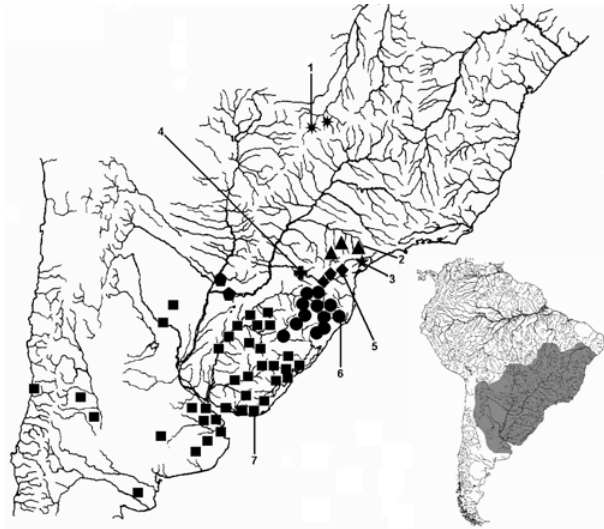
Fig. 1. Collection localities of Cnesterodon species: C . septentrionalis (eight-pointed stars, 1), C . hypselurus (tri- angles, 2), C . iguape (five-pointed stars, 3), C . omorgmatus (cross, 4), C . carnegiei (lozenges, 5), C . raddai (pentagons), C . brevirostratus (circles, 6), and C . decemmaculatus (squares, 7). Some symbols represent more than one lot or locality. Numbers represent type